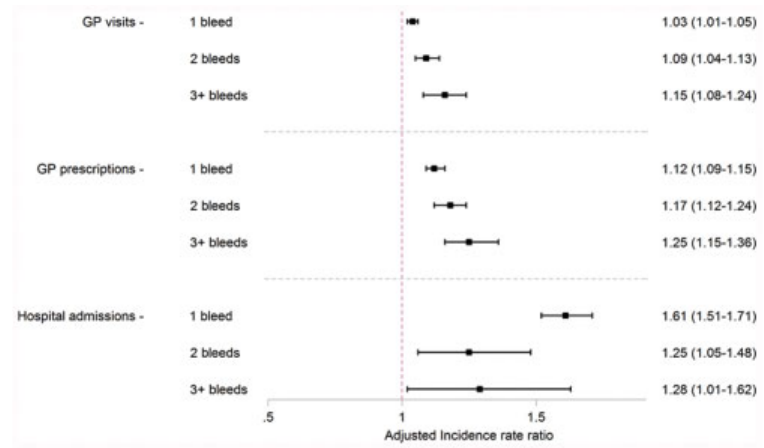
Fig. 5 Forest plot describing the incidence rate of GP visits, GP prescriptions, and hospital admissions during VKA treatment in the period following the fi rst, second, and third bleeds compared with the incidence in the period before any bleeds have occurred. Incidence rate ratios adjusted for all characteristics listed in ► Table 1 . GP, general practitioner; VKA, vitamin K